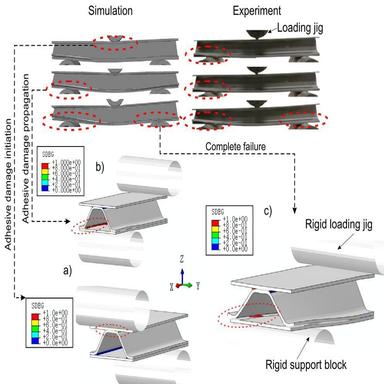
Deformation process of the ABCSS under three-point bending load of transverse loading direction, with adhesive a) damage initiation, b) damage propagation and c) complete failure modes.